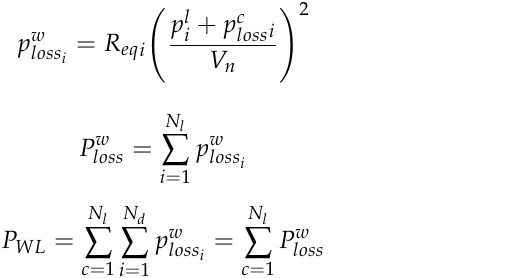
Figure 5. Short circuit faults. Figure 6. Total component cost at each voltage level. Component cost 24V